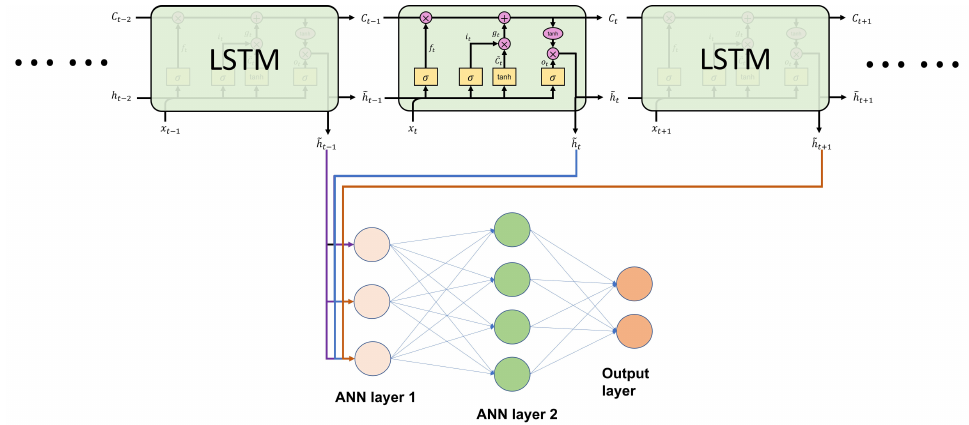
Figure 3. Architecture of the LSTM-ANN